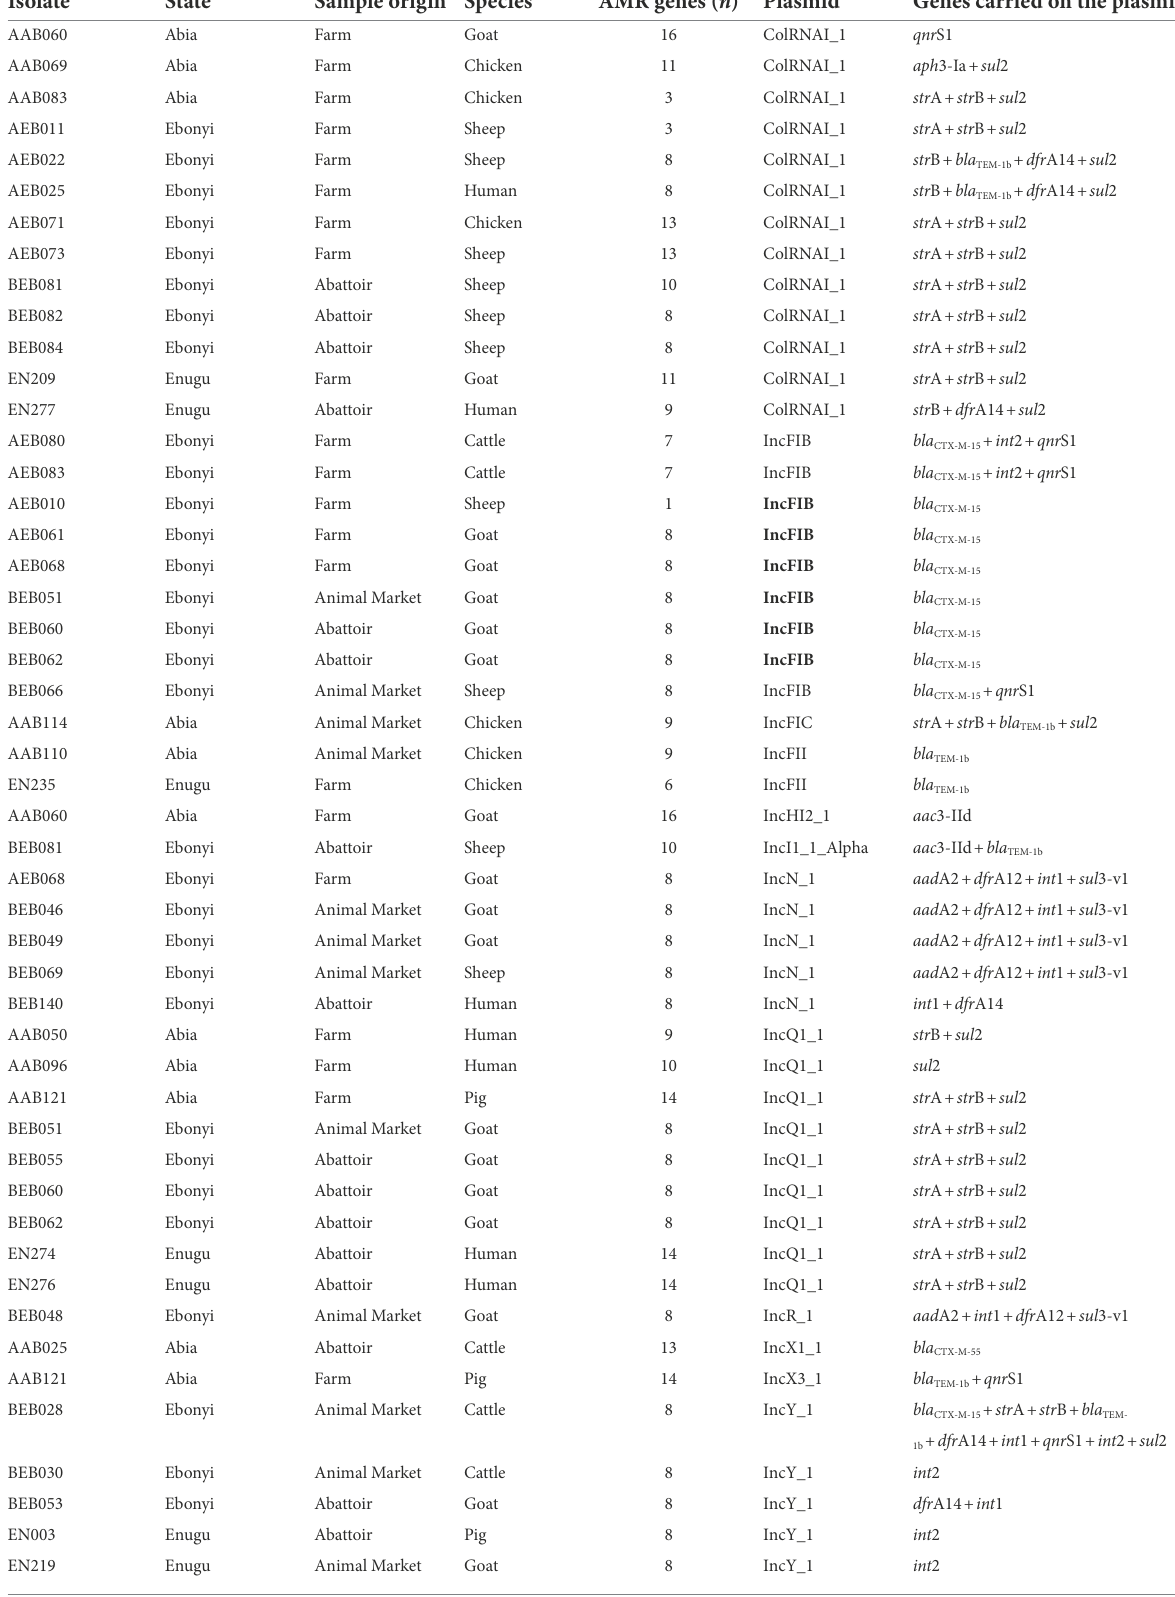
TABLE 3 Plasmid replicon and the antimicrobial resistance (AMR) genes harboured in the same contig.